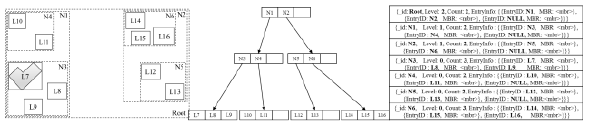
Figure 2. Flattening a R-tree into a MongoDB collection